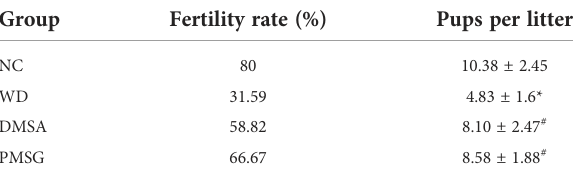
TABLE 3 Comparison of fertility of male mice in each group ( (cid:1) x s , n=10). Group